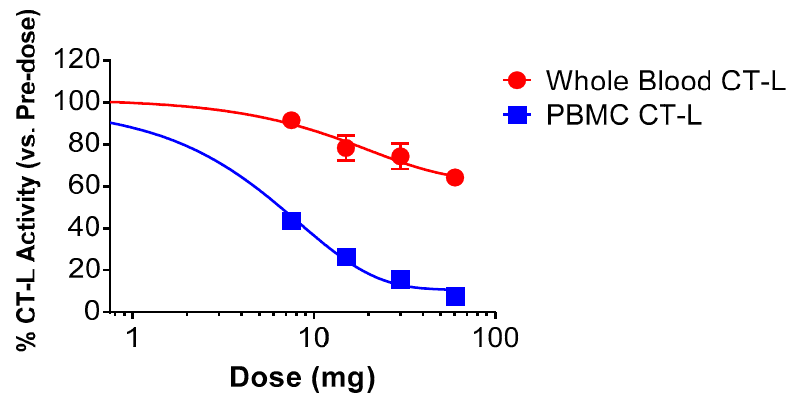
Figure 4. Inhibition of proteasome CT-L activity, 4 h following a single dose of KZR-616 in SAD cohorts of study KZR-616-001 (Mean ± SEM; N = 6/group).